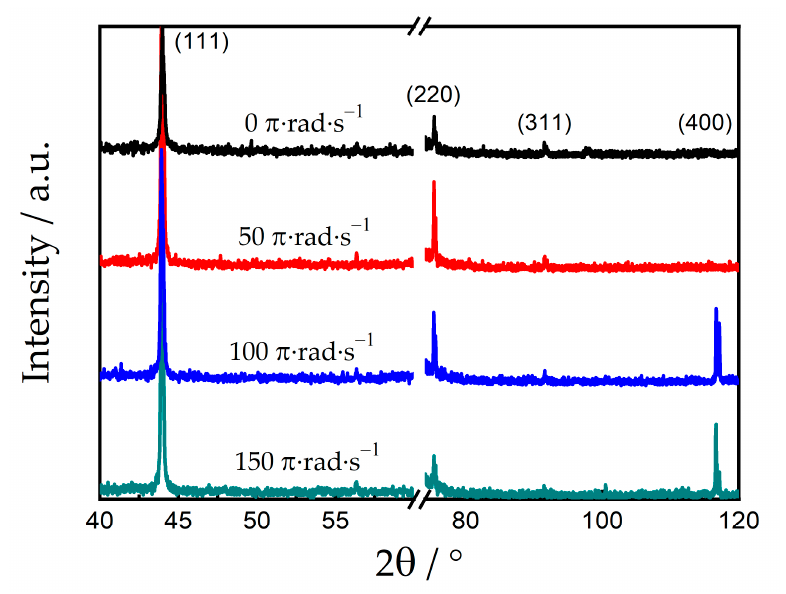
Figure 5. XRD patterns of CVD diamond films under a dynamic magnetic field with different angular frequencies (2 θ = 60–74 ◦ was broken to remove the sharp diffraction peak of the Si substrate).